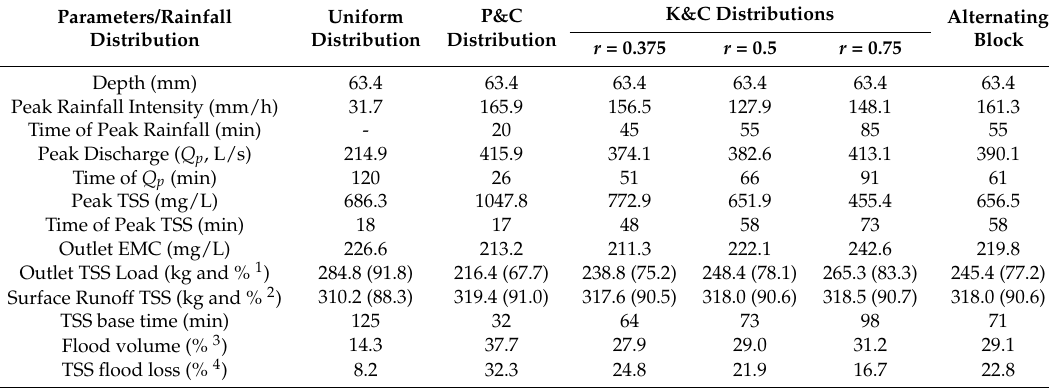
Table 5. Summary of simulated Q p and TSS characteristics for the three-year, 2-h design rainfall with different distributions